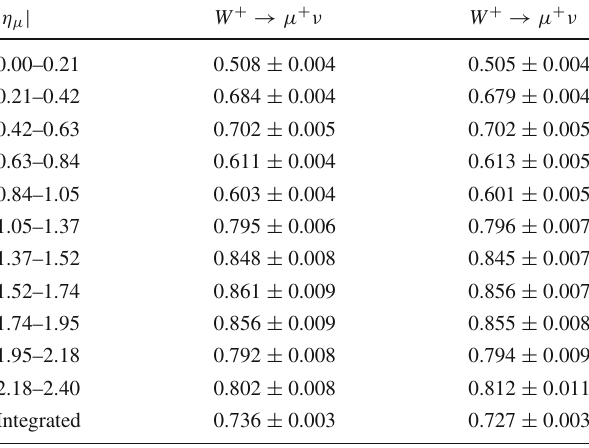
Table 2 The C W ± , i values with their associated systematic uncertain- ties as a function of | η μ | and the integrated global correction factor C W ± , each for W + and W −